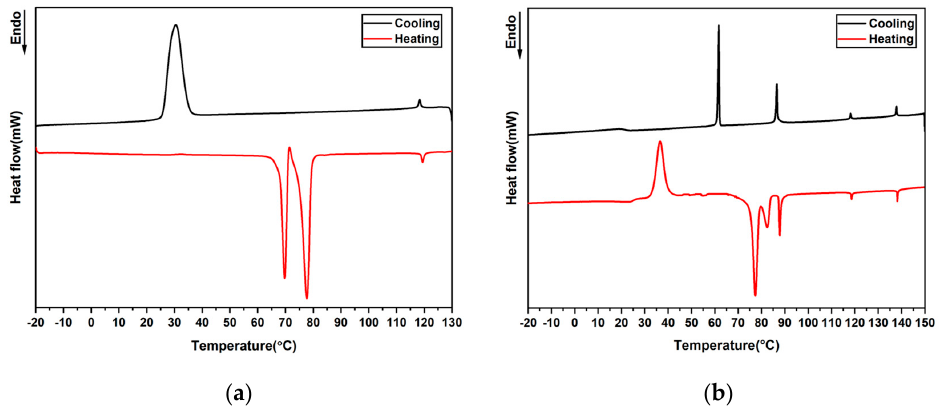
Figure 2. ( a ) DSC curves of pure Monomer 1. ( b ) DSC curves of pure Monomer 2. Table 1. Different concentrations of the oligomers.